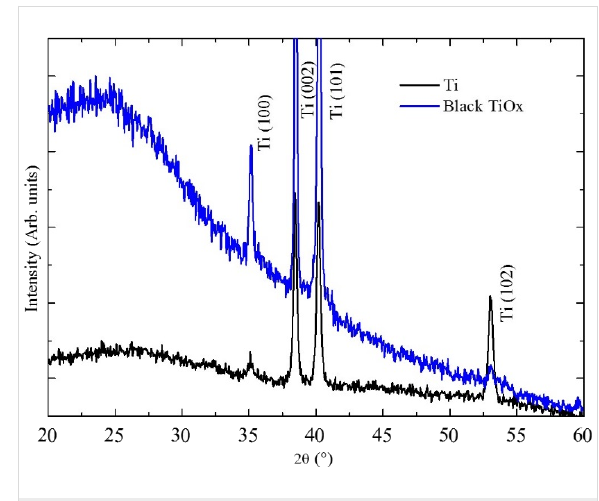
Figure 4: XRD spectra of the TiO x /Ti film and the Ti foil (before irradia- tion). The main characteristic peaks of titanium are indicated. The main feature of the black TiO x sample is the pronounced amorphous signal observed at low scattering